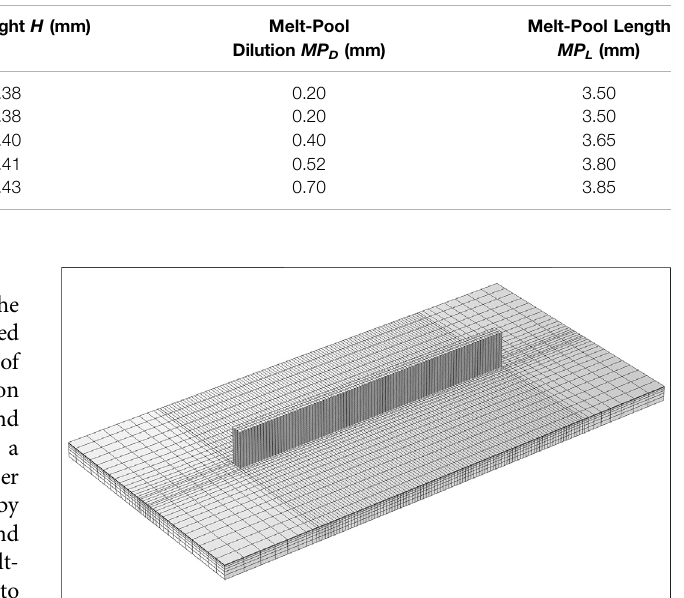
FIGURE 4 | Finite Element Mesh of substrate and wall